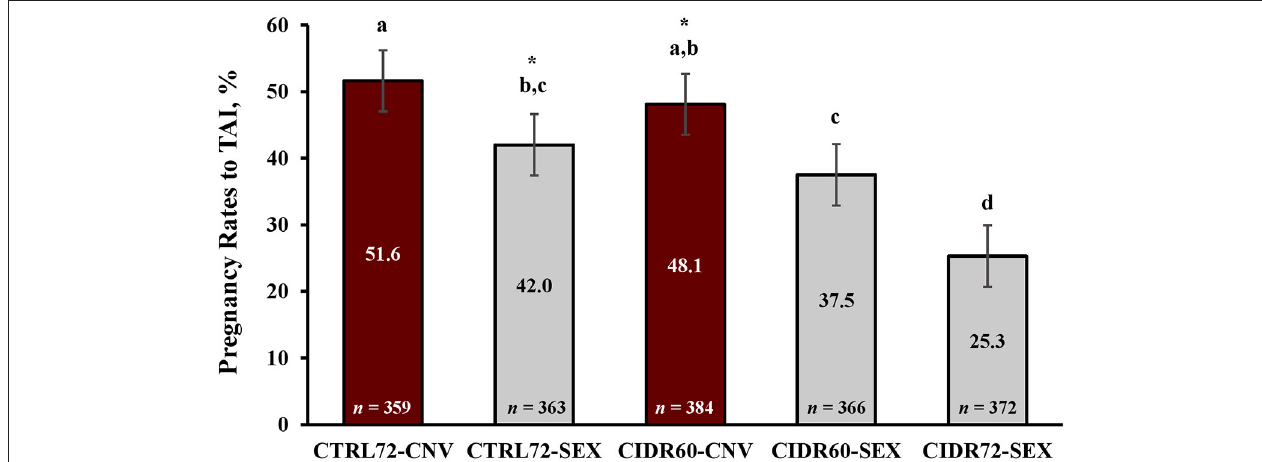
FIGURE 3 | Pregnancy rates to fixed-time artificial insemination (TAI) among treatments. CTRL72, PG-7 7-d CO-Synch + CIDR protocol; CIDR60, same as CTRL72 but CIDR inserted on Day − 7 and TAI performed 60h after CIDR removal; CIDR72, same as CIDR60 but TAI delayed to 72h after CIDR removal; CNV, conventional semen used for TAI; and SEX, sexed semen used for TAI. Pregnancy rates were determined via transrectal ultrasonography between 30 and 45 d after TAI. Least square means ± SEM are reported. a,b,c,d Bars with different superscripts differ ( P ≤ 0.05). *Indicates a tendency (0.05 < P ≤ 0.10) for treatment differences.